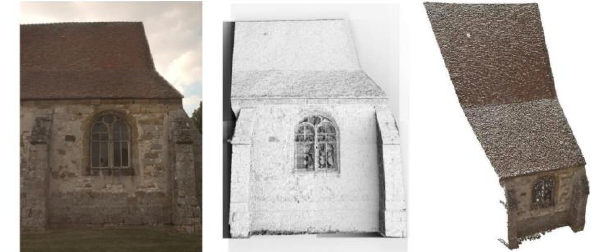
Figure 2: The multi-stereo image matching method: the master image (left), the matching result in the last pyramidal step (center) and the generated colorized point cloud (right) As orientation and position of each image are considered at the moment of the generation of point clouds, the superposition of each point cloud associated to each master image permits to create directly the dense point cloud of the building (Figure 3).